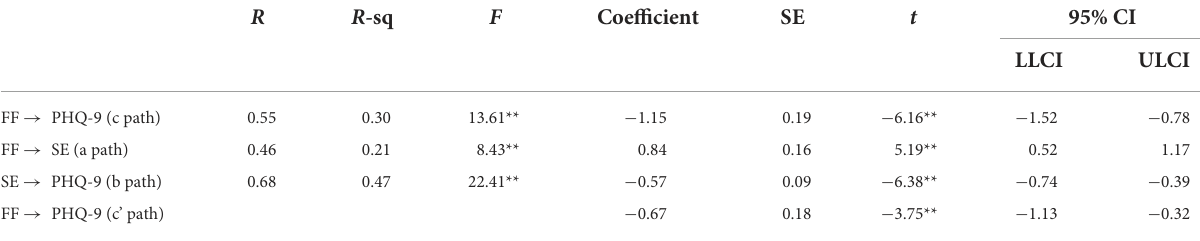
TABLE 3 Mediating effect of self-esteem on the relationship between the family function and PHQ-9 ( N = 133). R R -sq F Coefficient SE